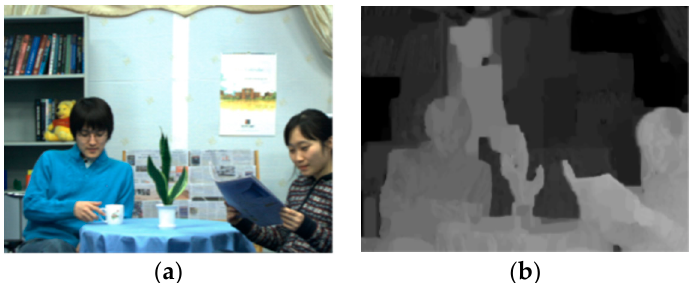
Figure 1. Example of the multiview video plus depth (MVD) format including a texture image ( a ) and a depth map ( b ).